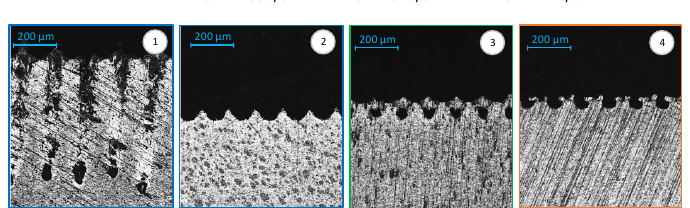
z behavior as a function of V s . Coatings 2017 , 7 , x FOR PEER REVIEW